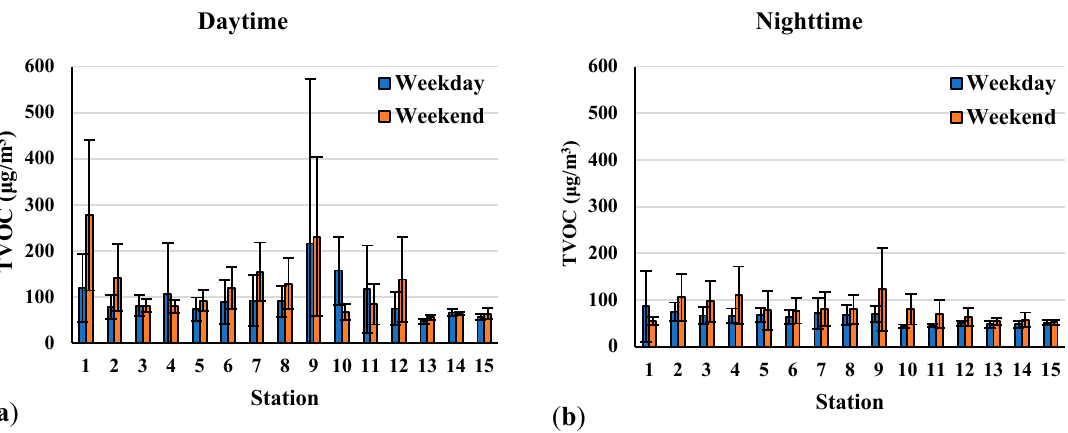
Figure 6. Average TVOC concentrations for daytime and nighttime for all 15 stations. ( a ) TVOC concentrations for daytime, and ( b ) TVOC concentrations for nighttime.